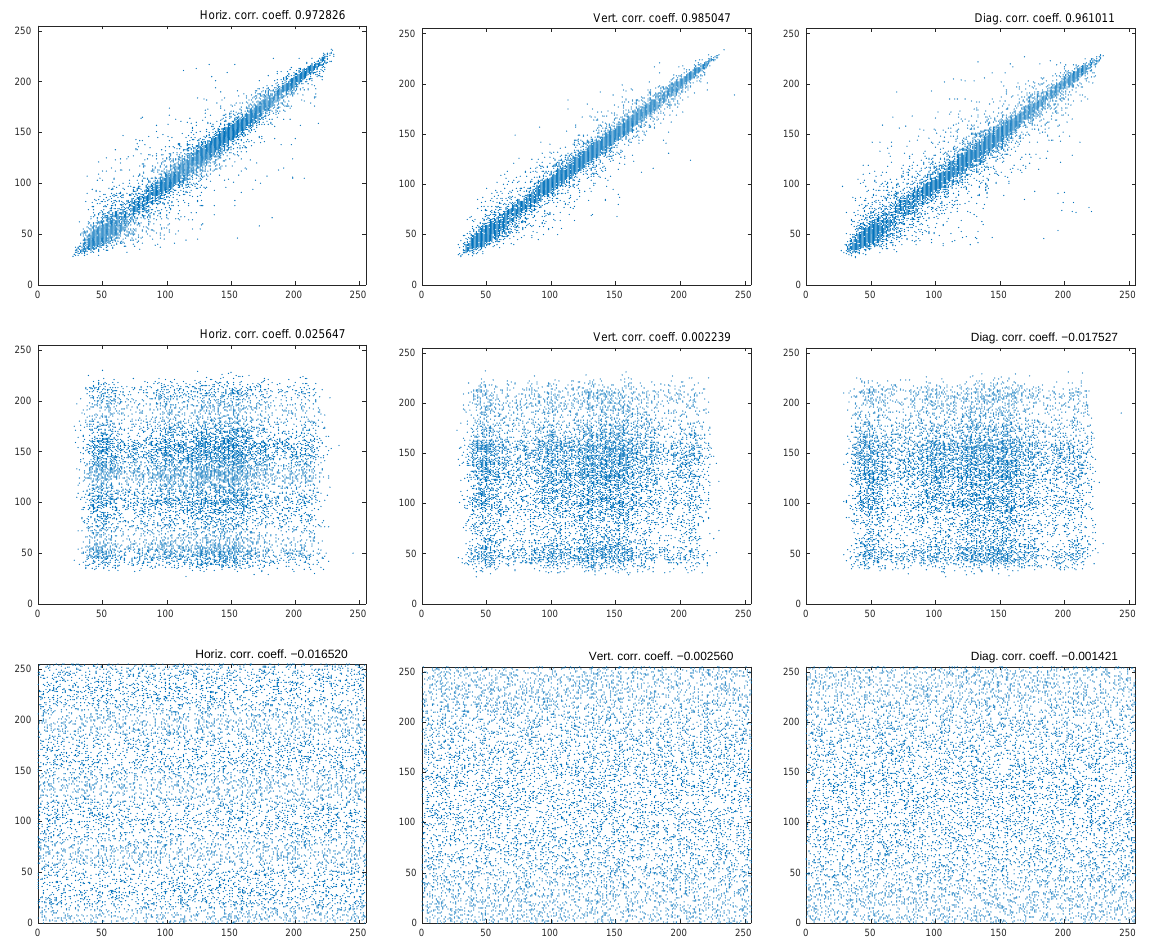
Figure 8. Point plots of (cid:96) = 10,000 adjacent pairs of pixels chosen randomly in the horizontal ( left ), vertical ( middle ), and diagonal ( right ) directions in the grayscale plain image Lena ( top ), shuffled image ( middle ), and cipher image ( bottom